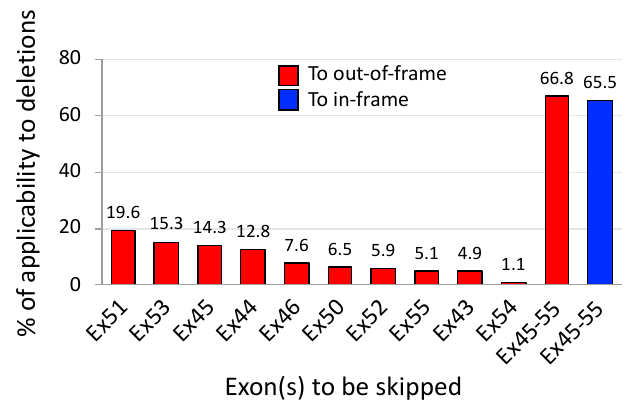
Figure 5. Theoretical applicability of exons 45–55 skipping to patients with out-of- and in-frame deletions. 3232 and 1611 patients with out-of-frame and in-frame deletions, respectively, were extracted from the Leiden DMD database (as of 22 June 2018). The applicability to out-of- (red) and in-frame deletions (blue) was examined. As single exon skipping has not been fully correlated with functional correction, the applicability only to out-of-frame deletions is shown. In contrast, the applicability of exons 45–55 skipping thought to enable the production of functionally improved dystrophin, is shown for both frame types.